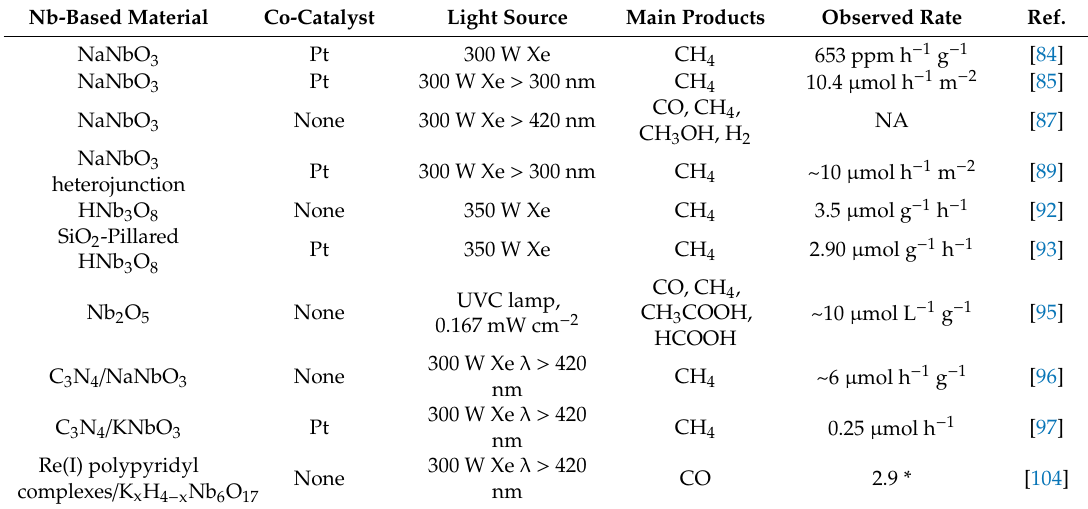
Table 4. Summary of the photocatalytic activity of Nb-based compounds combined with distinct materials towards CO 2